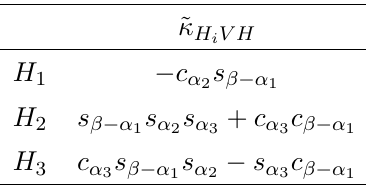
Table 5 . The coupling factors ~ (cid:20) H as de(cid:12)ned in the Feynman rules eqs. (2.31) and (2.33) for i V H the H i couplings to a pair of Higgs and gauge